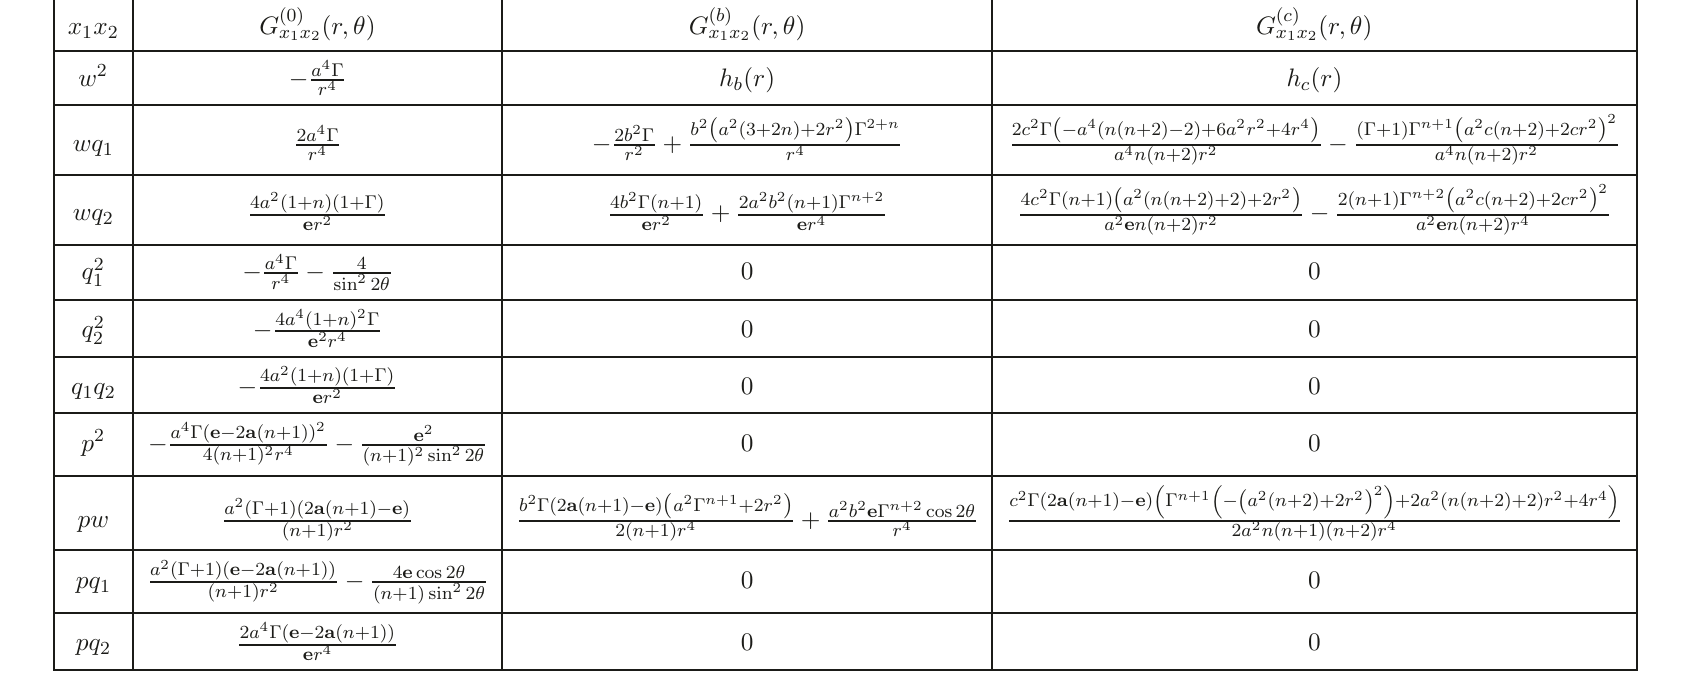
Table 3 . G x ( r, θ ) for the (2 , 1 , n ) original and supercharged 1 x 2